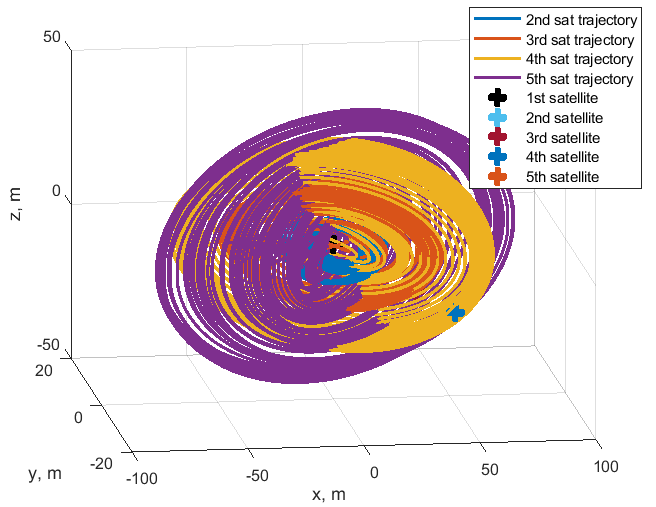
Figure 24. Relative trajectories.